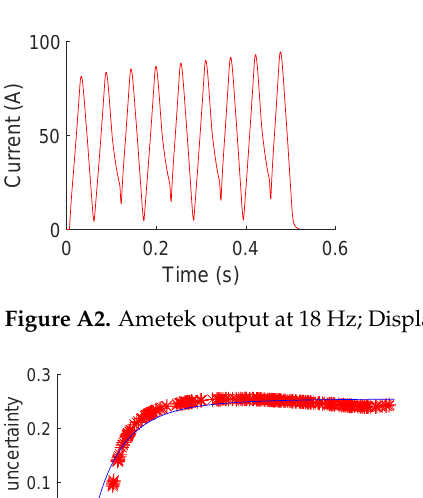
Figure A1. Example microstructure of two separate AA7075 sheets.